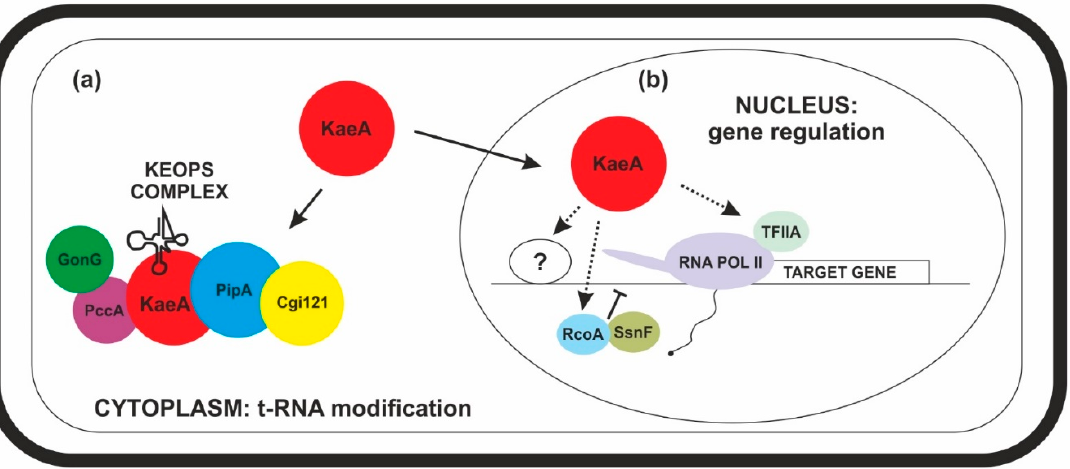
Figure 3. KaeA, a protein with a dual function. ( a ) Primary role of KaeA: participation in t6A 37 tRNA modification. ( b ) Additional nuclear function of KaeA: regulation of gene expression.